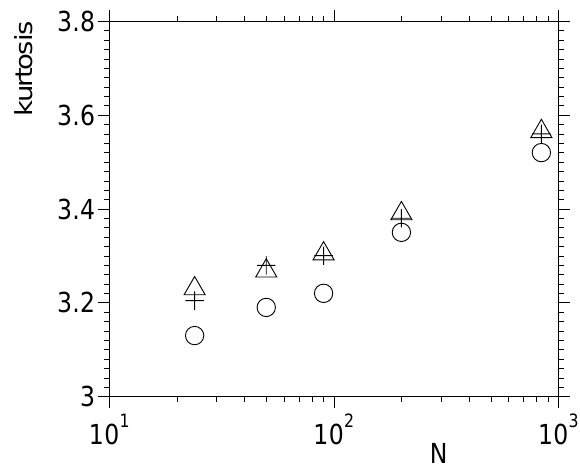
Fig. 7. Maximum kurtosis as a function of the directional spreading coefficient N : without current ( ◦ ); with current at 110deg (+); with current at 120deg ( 4